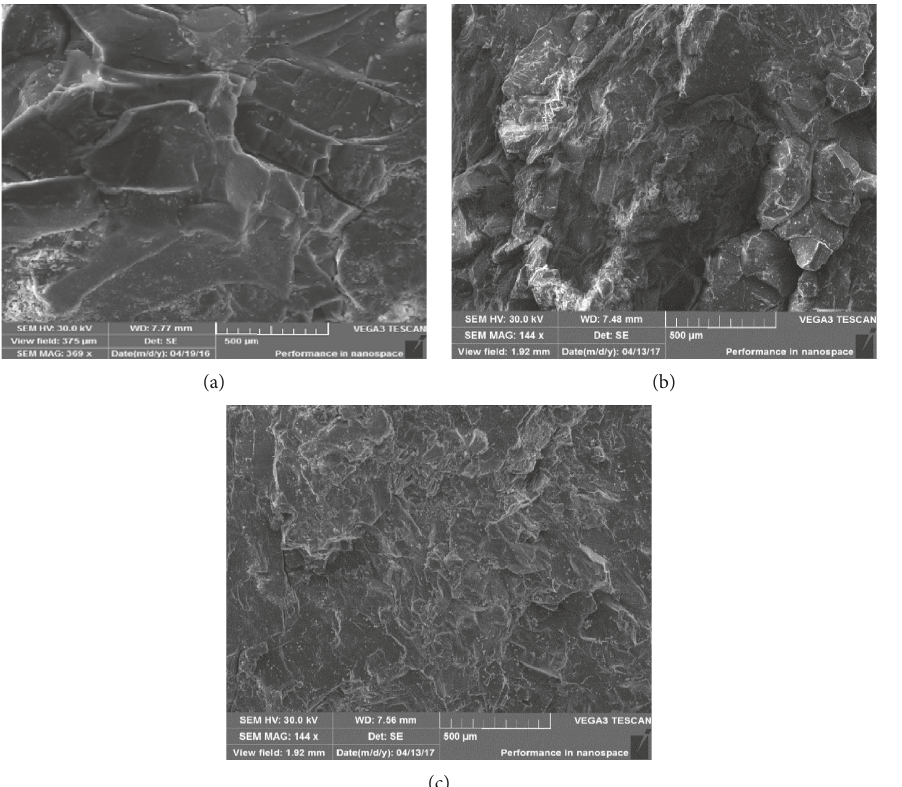
Figure 14: SEM images of tonalite (a) without treatment and after freeze-thaw cycling with (b) a minimum temperature of − 30 ° C and (c) a minimum temperature of − 50 ° C.